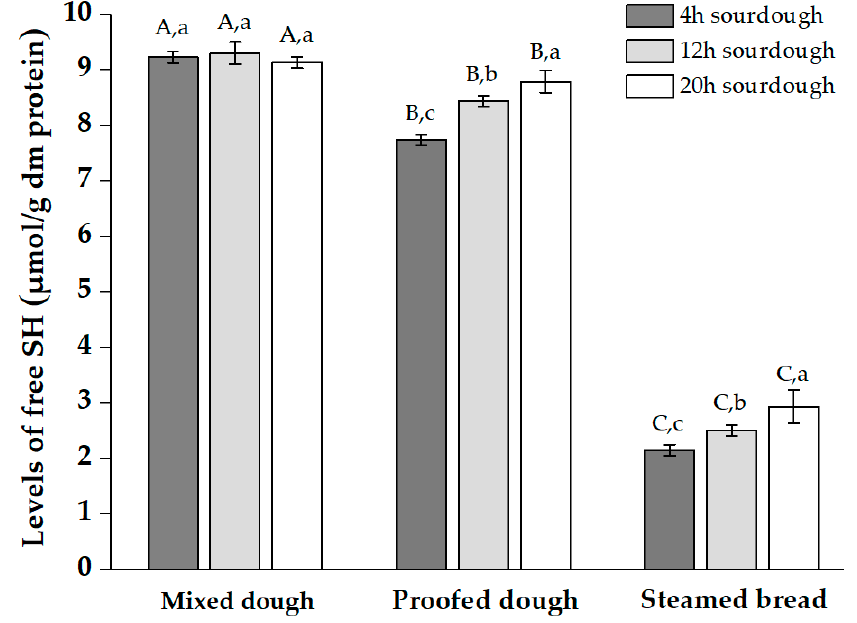
Figure 8. The level ( µ mol / g dm protein) of free sulfhydryl (SH) of mixed dough, proofed dough, and steamed bread with different acidification levels of sourdough. The three results in each group were added 4 h, 24 h, and 36 h fermented sourdough, respectively.